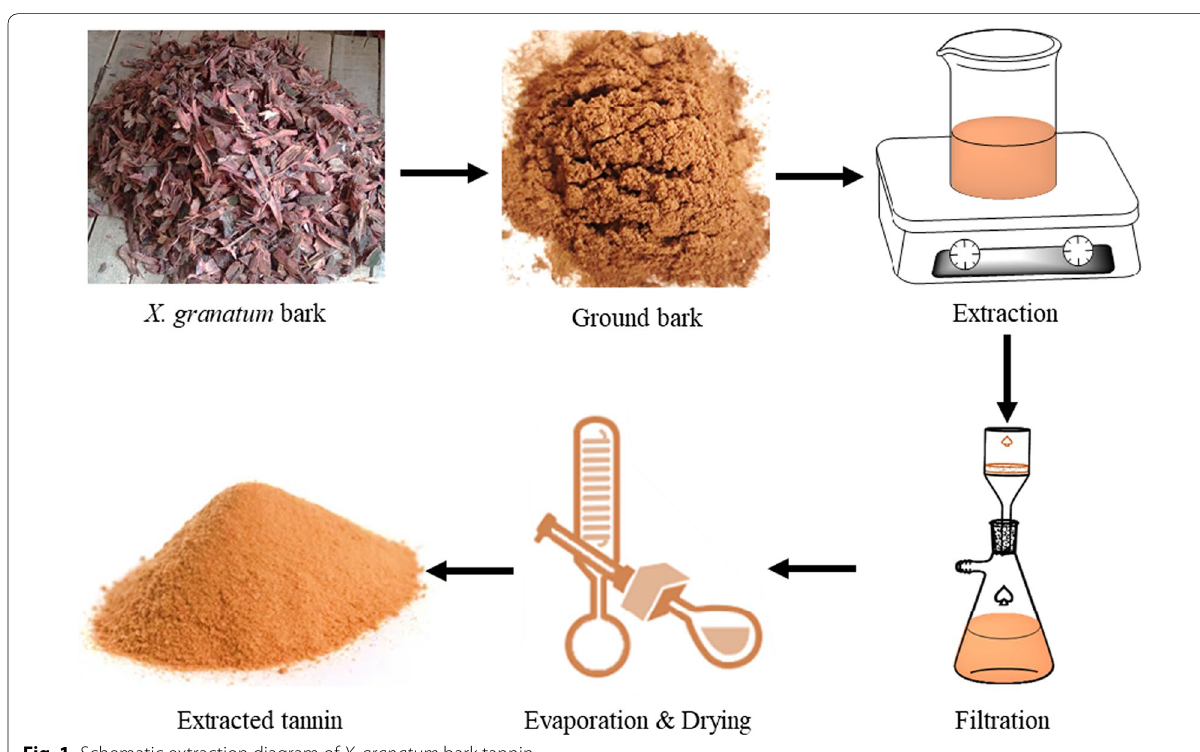
Fig. 1 Schematic extraction diagram of X. granatum bark